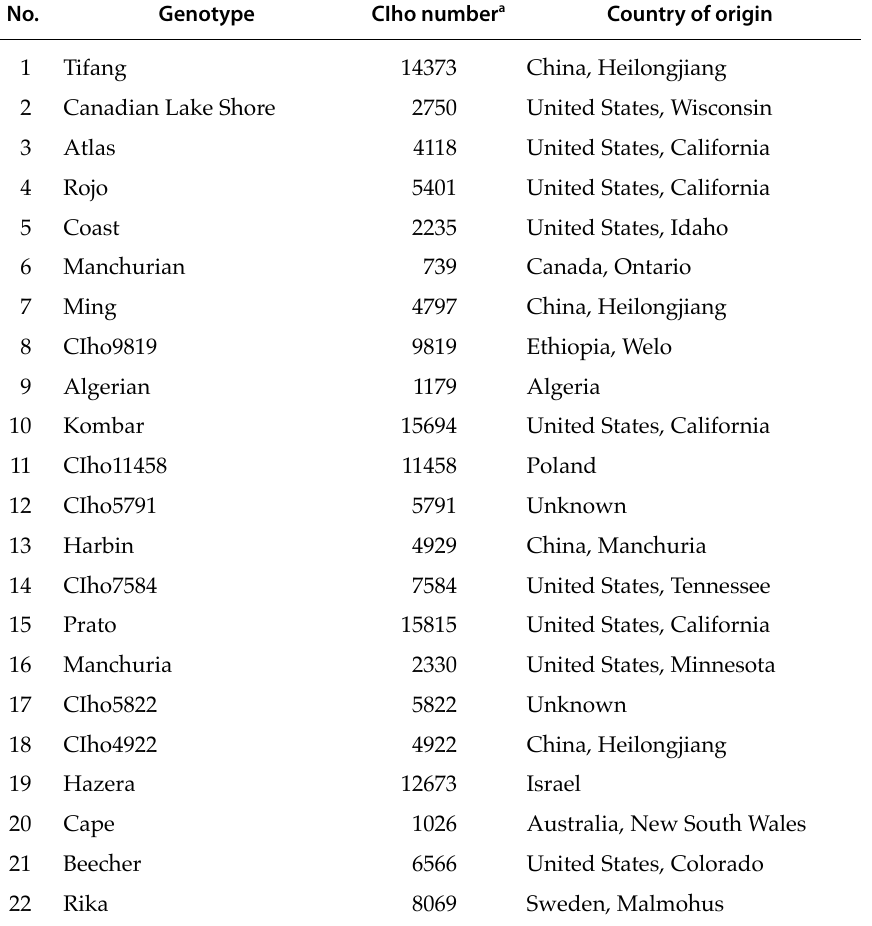
Table 2. Barley genotypes used as differential lines to evaluate the pathogenic variability of isolates of Pyrenophora teres f. teres